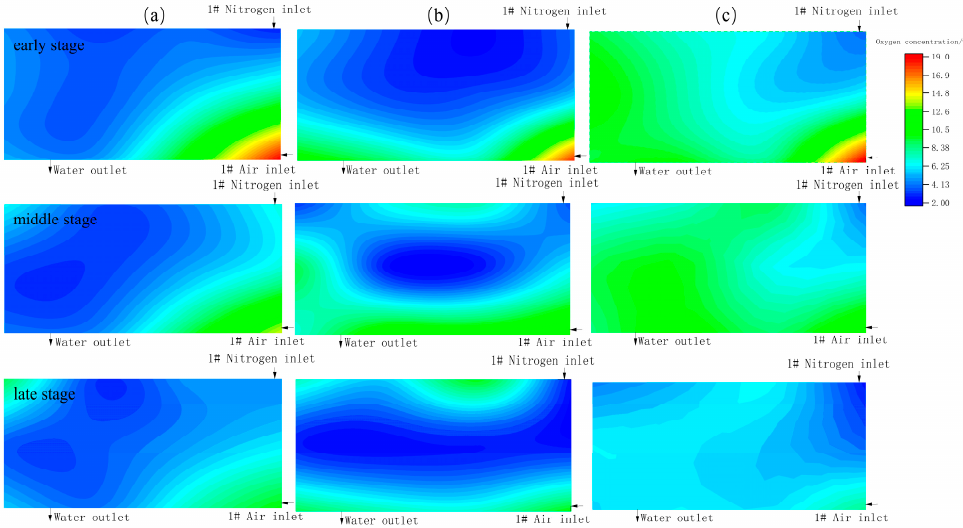
Figure 6. Change characteristics of SC hazardous area in the goaf under different nitrogen injection flow rates. ( a ) 4L/min, ( b ) 5L/min, ( c ) 6L/min.